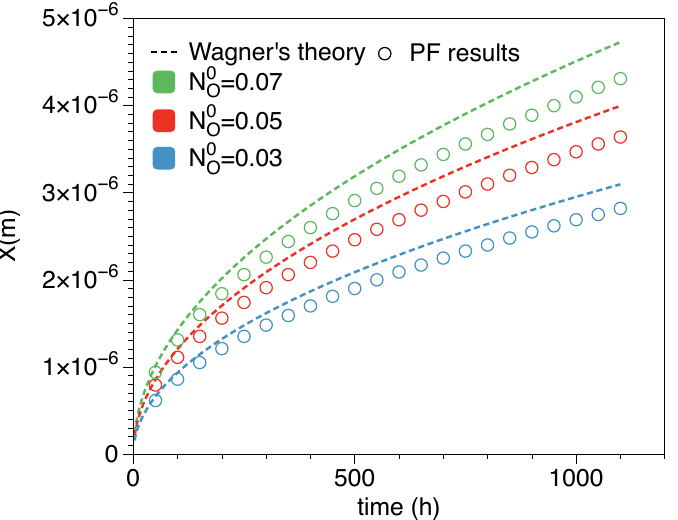
Figure 4. Comparison of the scale growth of the Cr 2 O 3 layer obtained from the PF results and the predictions of Wagner’s theory for different oxygen concentrations at the Cr 2 O 3 /gas interface, i.e., N 0 = 0.07, 0.05 and 0.03, in Fe-22 wt.%Cr alloy at T = 1073 O